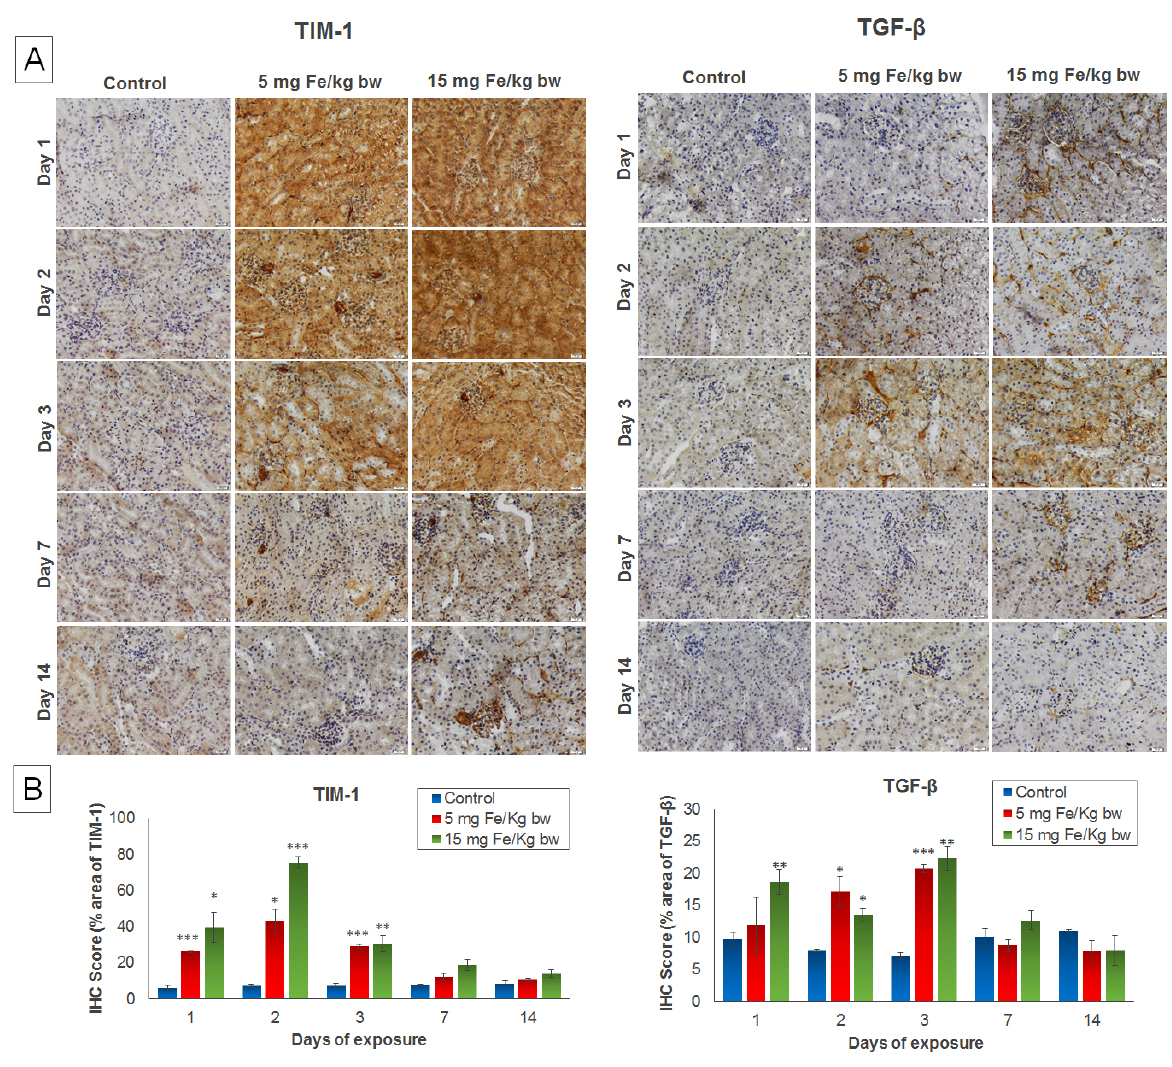
Figure 3. The effect of IONPs encapsulated in phospholipid-based micelles on the TIM-1 and TGF- β expression and distribution in the CD1 mice kidney tissue at 1, 2, 3, and 7 days post-exposure. ( A ) Immunohistochemistry (IHC) images; ( B ) quantification of IHC images. The IHC score was expressed in percentage of the stained area. The results are calculated as the mean ± standard deviation (SD) and are considered statistically significant when * p < 0.05; ** p < 0.01; *** p < 0.001 versus the control group. Scale bar: 20 µm.